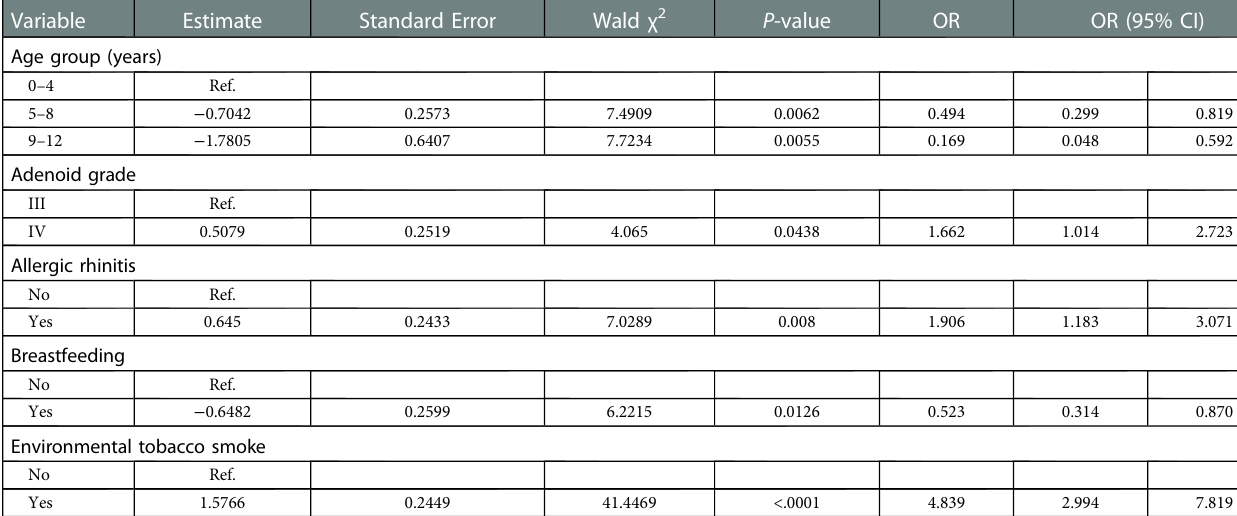
TABLE 2 Results of multivariate logistic regression analysis of pediatric patients with adenoid hypertrophy with otitis media with effusion. Variable